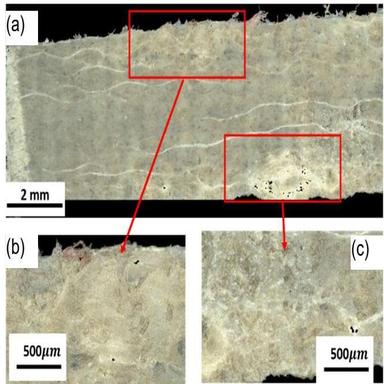
a) the achieved surface profile of the NFRC via orthogonal cutting process with significant surface integrity issues in the localized regions (b) & (c).